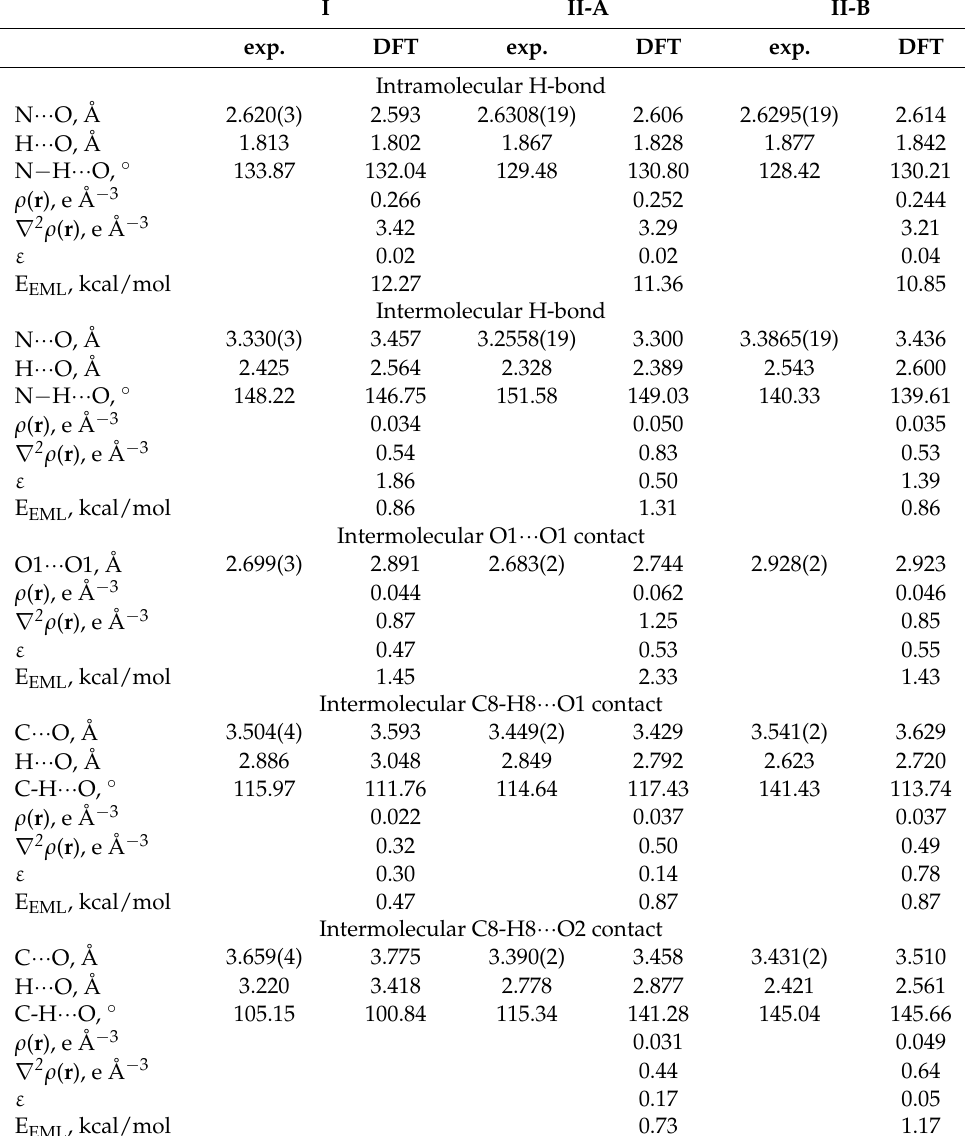
Table 2. Geometric parameters of bonding interactions in forms I and II and characteristics of the electron density ρ ( r ) and its